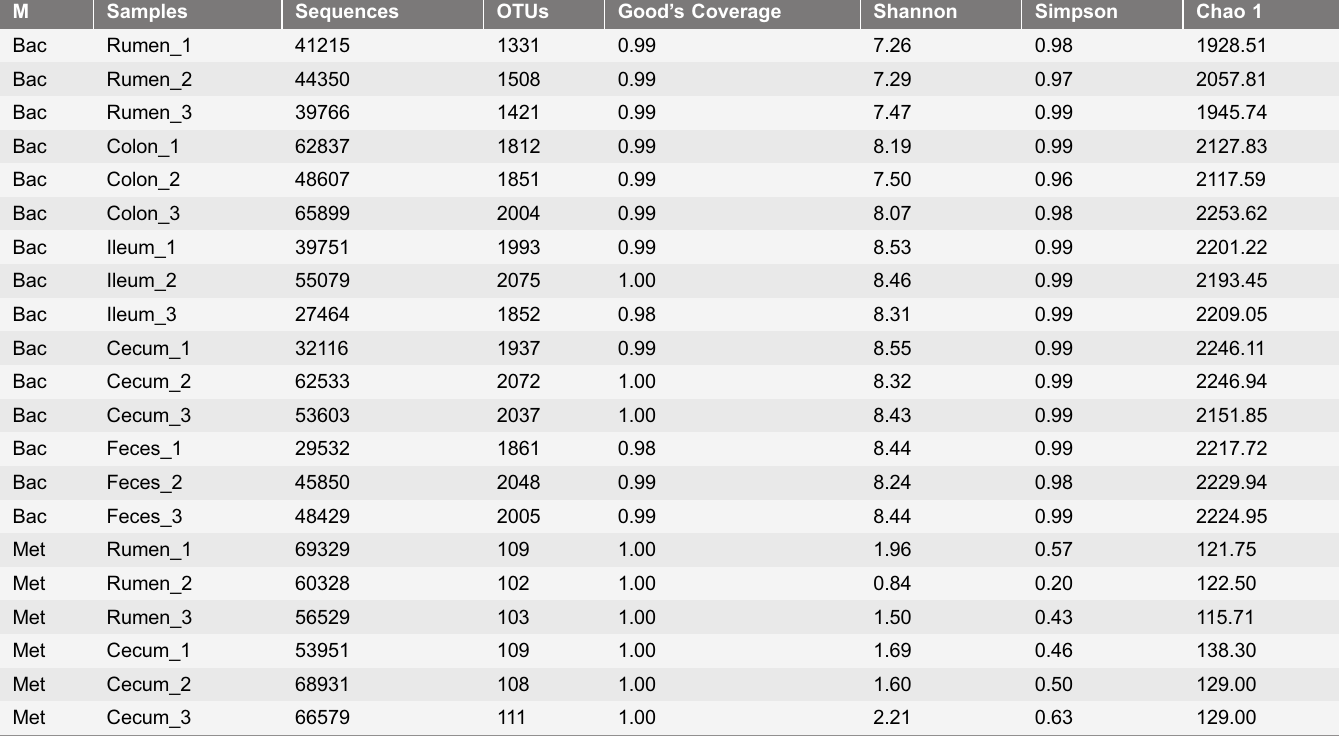
Table 1. Summary of next generation sequencing